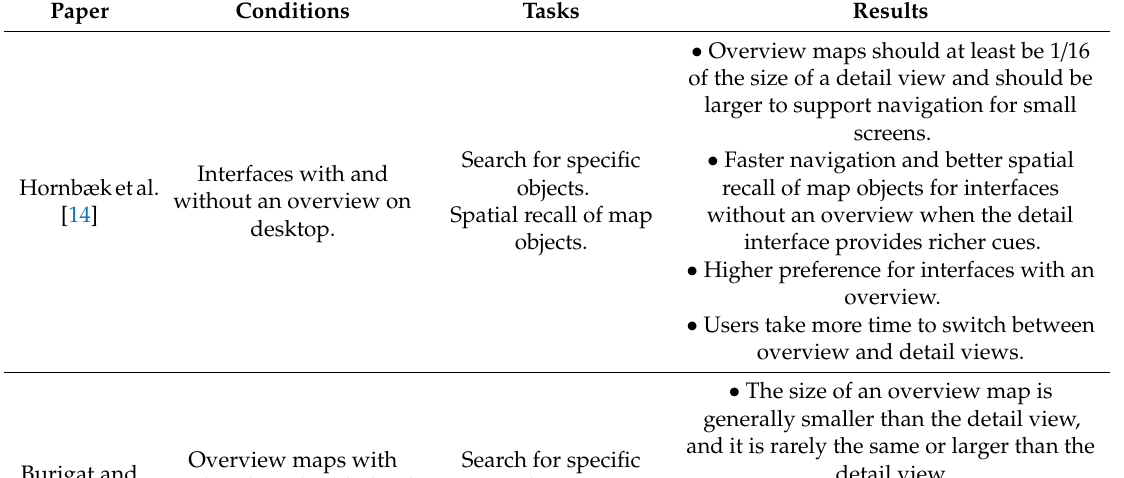
Table 1. Overview map studies on size or